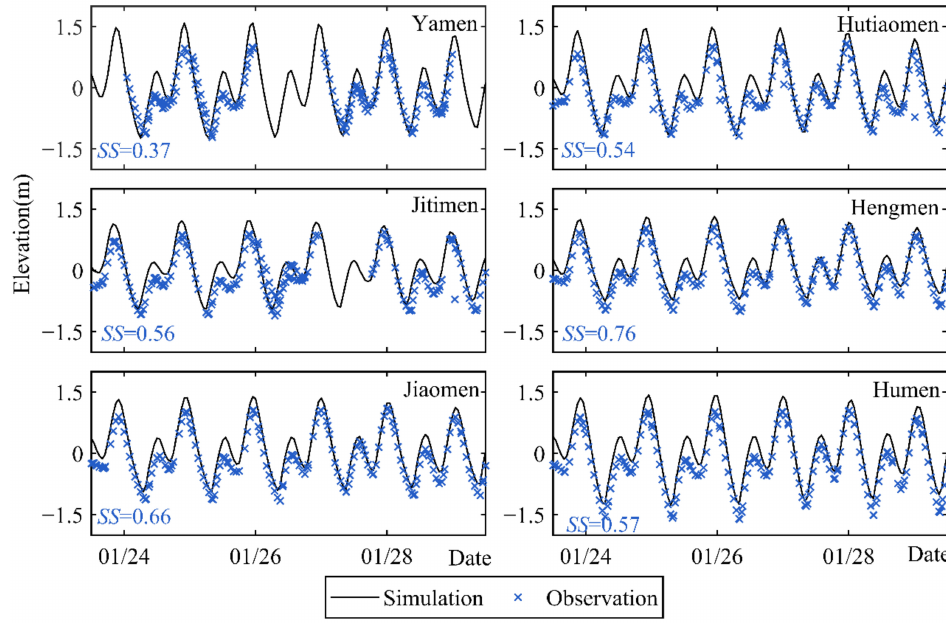
Figure 3. Validation of water surface